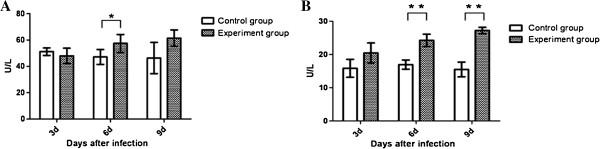
Liver function enzymes. (A) Alanine aminotransferase (ALT) and (B) aspartate aminotransferase (AST) in the serum of duck TMUV-infected mice (n = 5) infected via the i.c. route, on days 3, 6 and 9 post-infection. The asterisks indicate differences that are significant (* P < 0.05, ** P < 0.01).